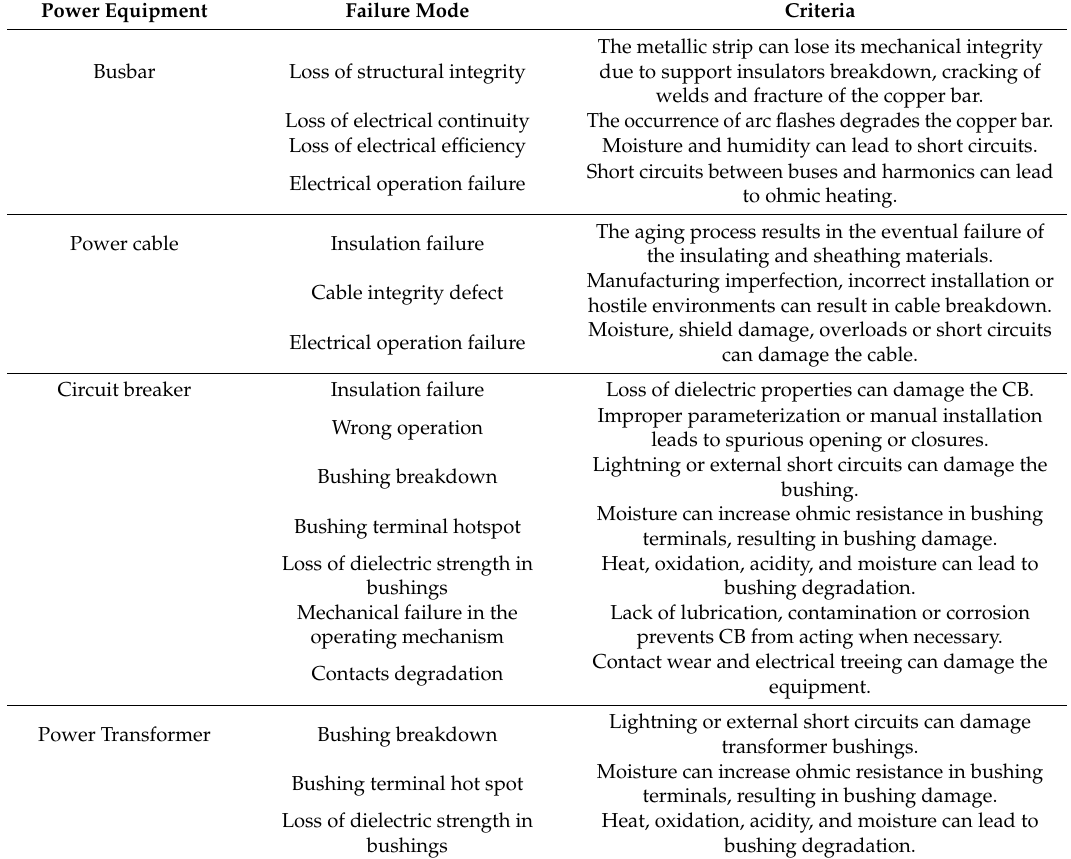
Table 7. Failure modes for power equipment considered for